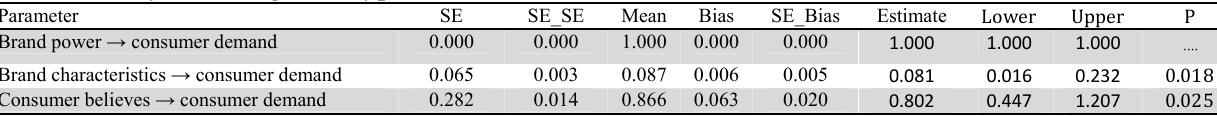
The summary of testing four